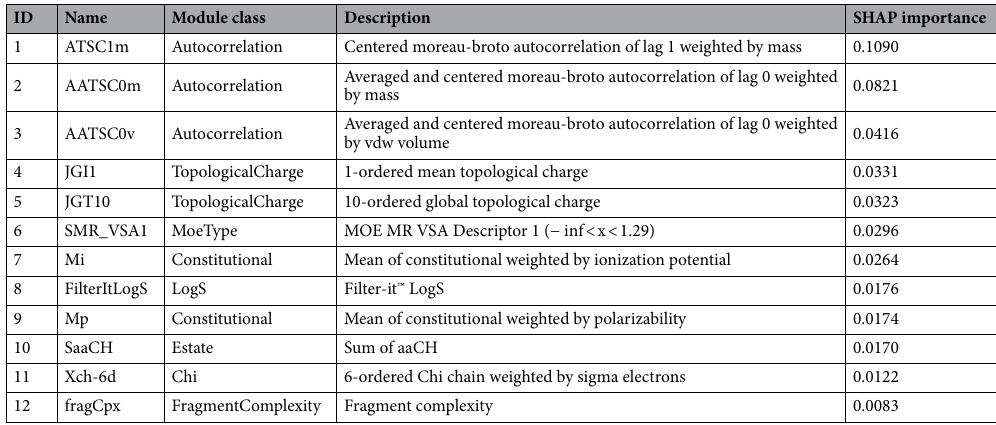
Table 2. Features selected according to the best model. SHAP values represent the contribution of each feature to the prediction. The greater the value, the higher the